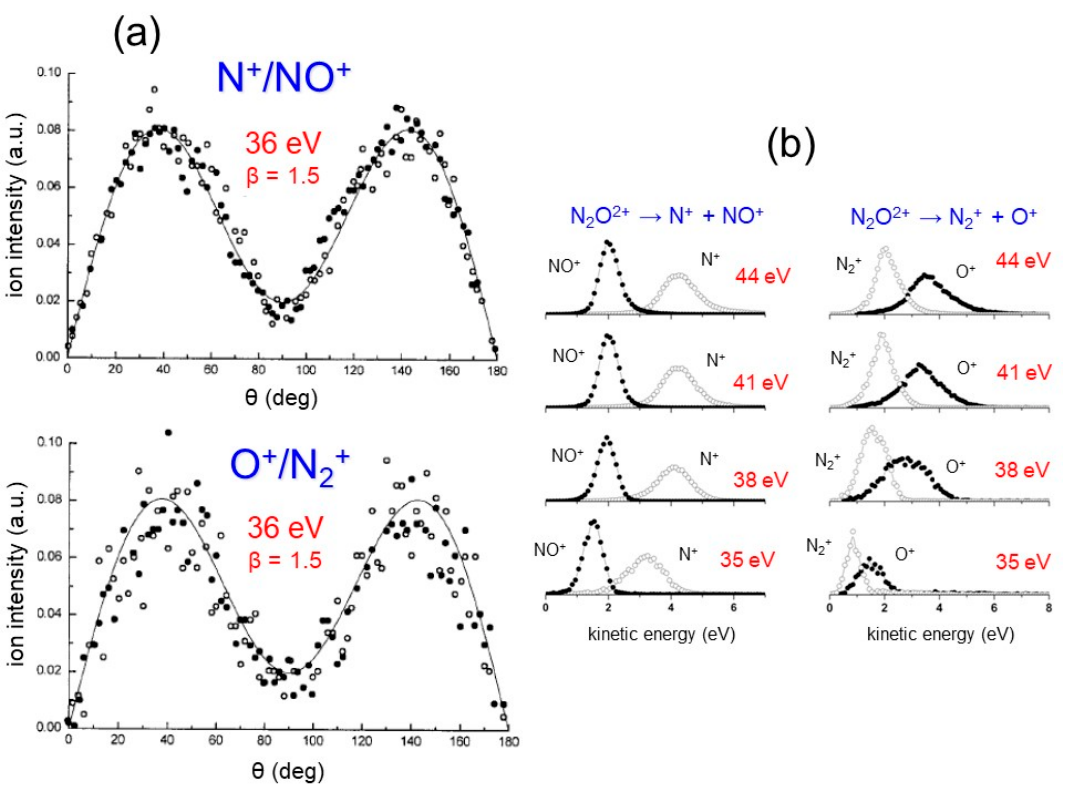
Figure 8. Data from the double photoionization of N 2 O by synchrotron radiation in the 30–50 photon energy range: ( a ) the angular distributions obtained for the two fragmentation channels (see Equations (17) and (18) in the text) at a photon energy of 36 eV [80]; the black points refer to the diatomic ions NO + or N 2 + and the open circles to the atomic N + or O + ones; the best fitting of the experimental data allowed the determination of the anisotropy parameter β (see text); ( b ) the KER distributions for single product ions of reactions (17) and (18) occurring by the Coulomb explosion of the metastable N 2 O 2 + molecular dication [80].